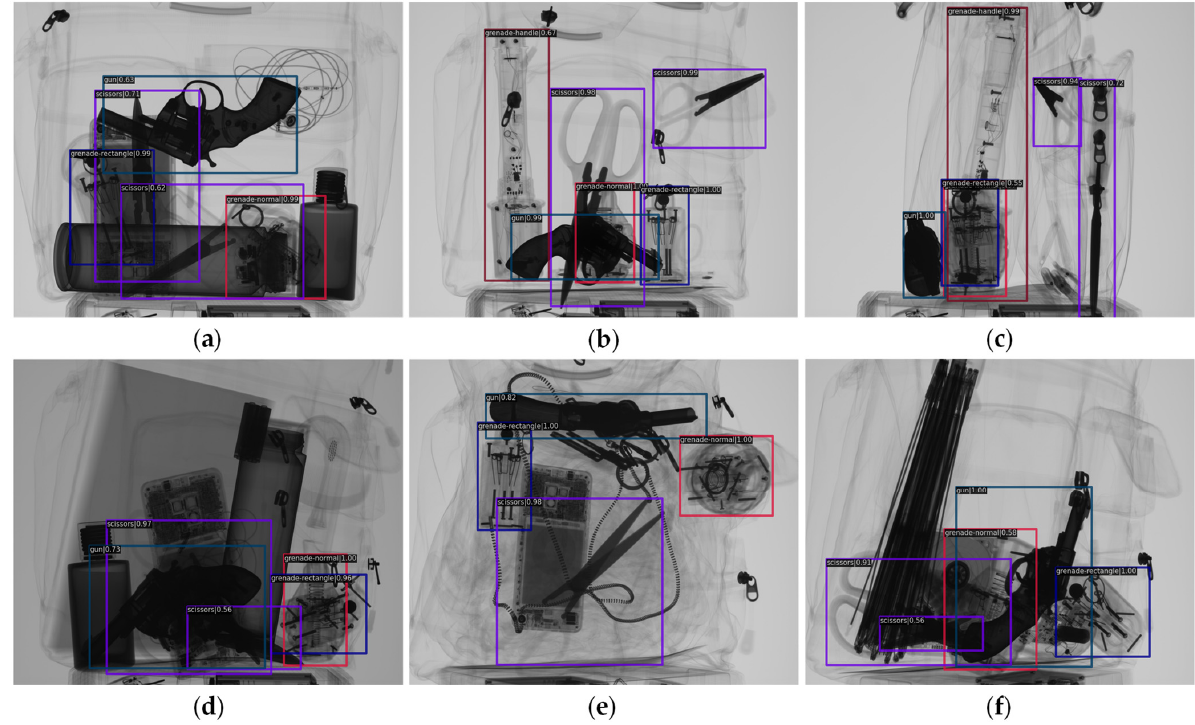
Figure 13. Detection results obtained by proposed YOLO-T network model: ( a ) test image 1; ( b ) test image 2; ( c ) test image 3; ( d ) test image 4; ( e ) test image 5; ( f ) test image 6.